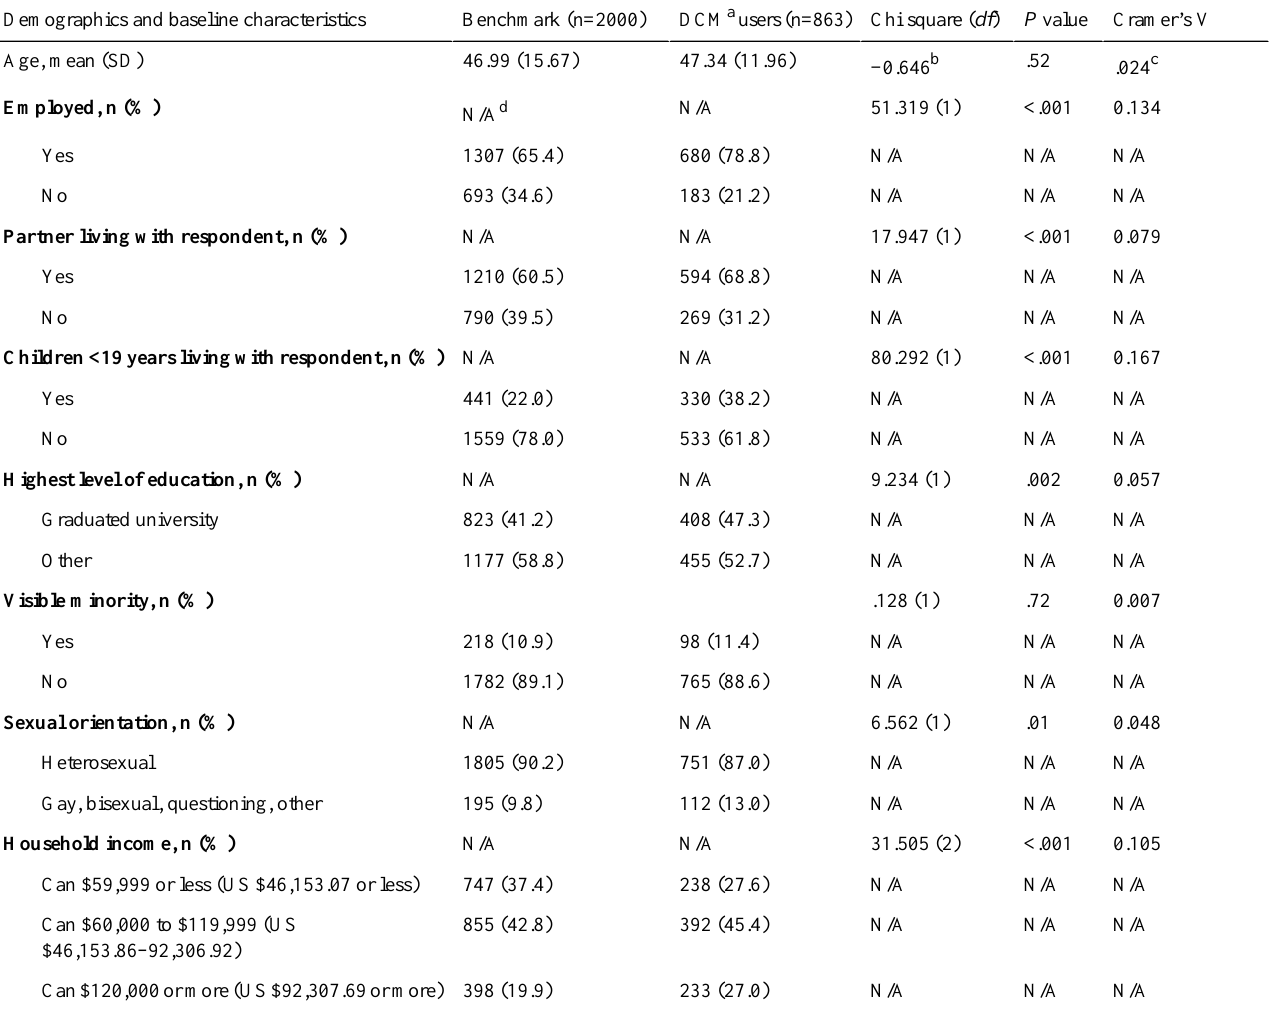
Table 1. Benchmark versus Don’t Change Much users’sample